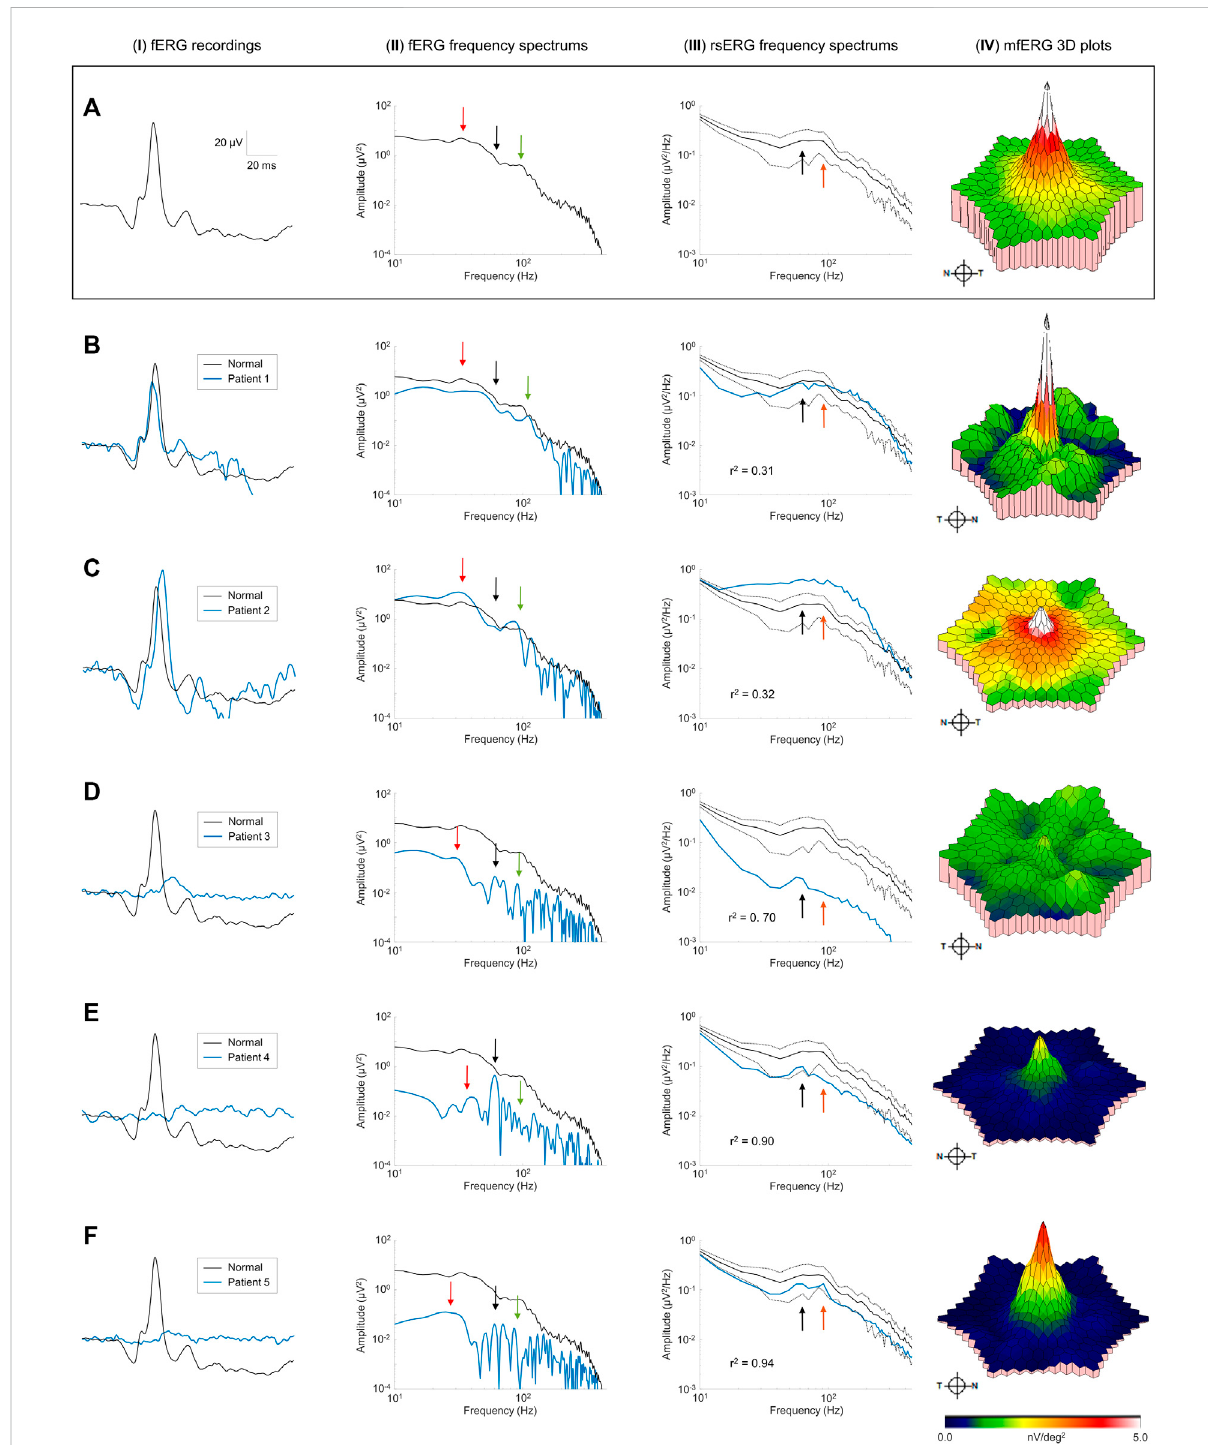
FIGURE 6 Pathological cases and the rsERG. Examples of pathological cases (blue traces) compared to normal subjects (black traces). Row (A) shows examples of normal data, while each subsequent row (B – F) shows a different patient. The fi rst column ( I ) shows the ISCEV standard photopic fERG ( fl ash: 3 cd s m − 2 , background light: 30 cd m − 2 ) recordings, with the associated frequency spectrums shown in the second column ( II ). The light- adapted 30 cd m − 2 white background light rsERG frequency spectrums are shown in the third column ( III ), with the normal subject mean ± standard deviations shown in black dashed lines. The last column ( IV ) shows the mfERG 3D plots, with the full mfERG data shown in Supplementary Figure S3. Black arrows show the 60 Hz component. Red arrows show the fERG slow component. Green arrows show the fERG fast component. OrangearrowsshowthersERG90 Hzfastcomponent. Ther 2 valuebetweenthenormalandpathologicalrsERGfrequencyspectrumsareshownon the bottom left corner of each fi gure. All r 2 values were signi fi cant ( p <